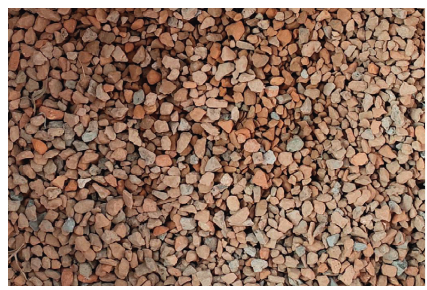
Figure 2: Recycled brick